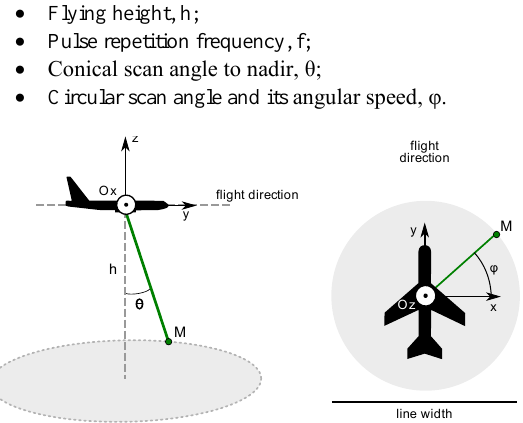
Figure 9. Schematic showing lidar simulator parameters.